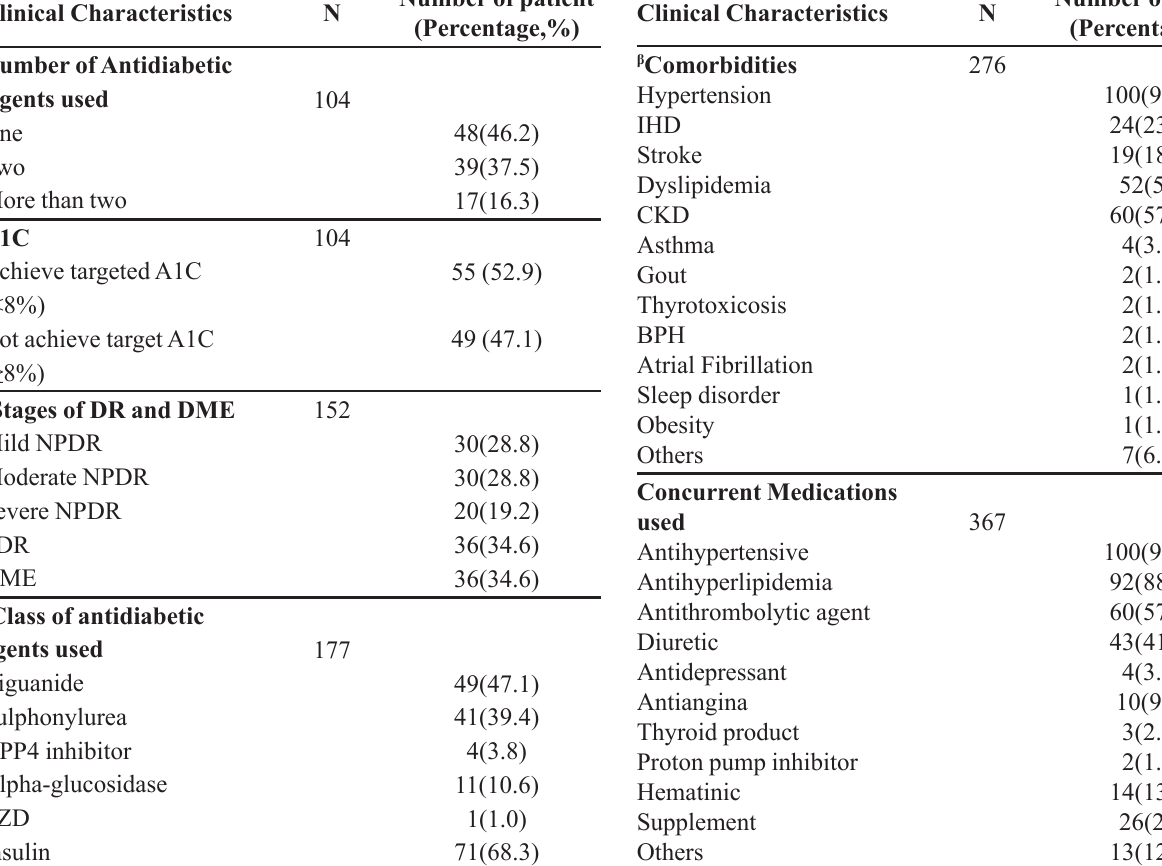
TABLE III - Clinical characteristic of patient (N=104) Clinical